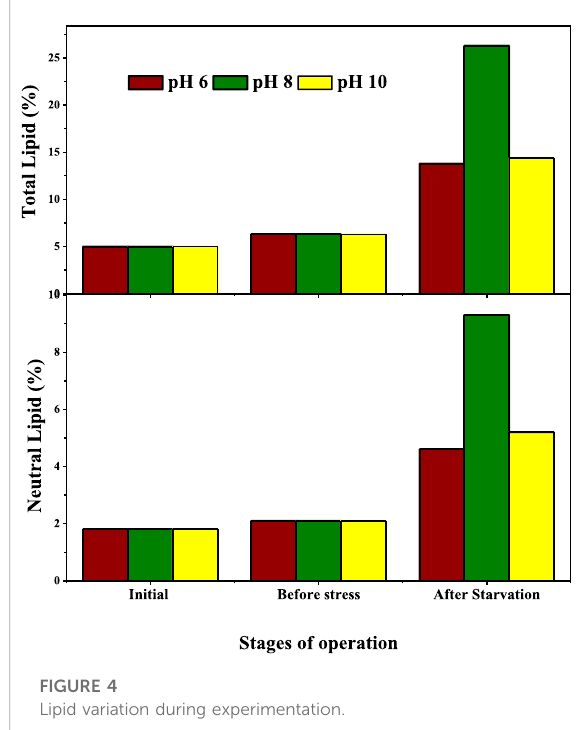
FIGURE 4 Lipid variation during